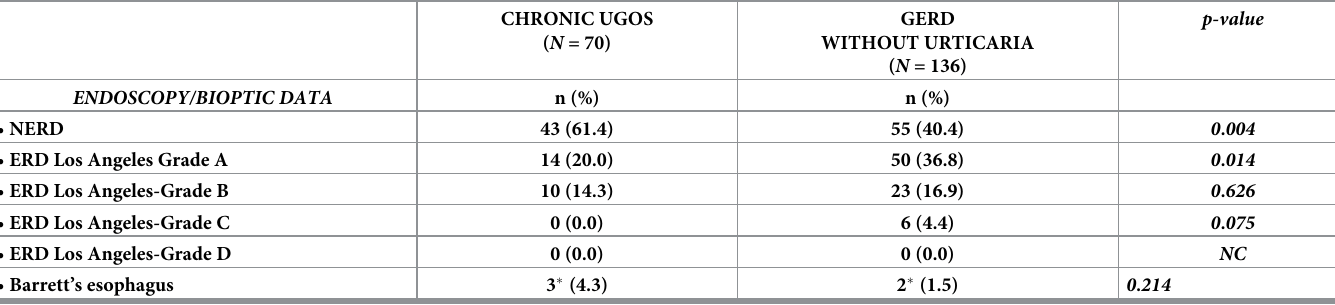
Table 7. Esophageal endoscopic findings in 205 patients suffering from gastro-esophageal reflux disease (GERD) with or without the overlap of chronic spontane- ous